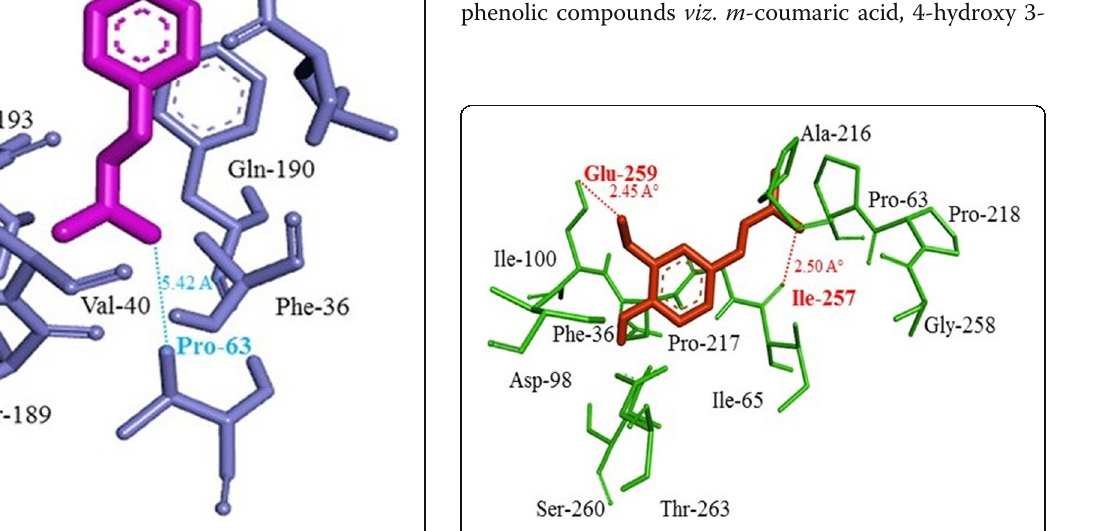
Fig. 8 Docking complexes 4-hydroxy 3-methoxy cinnamic acid-Bcl2- associated X (BAX)